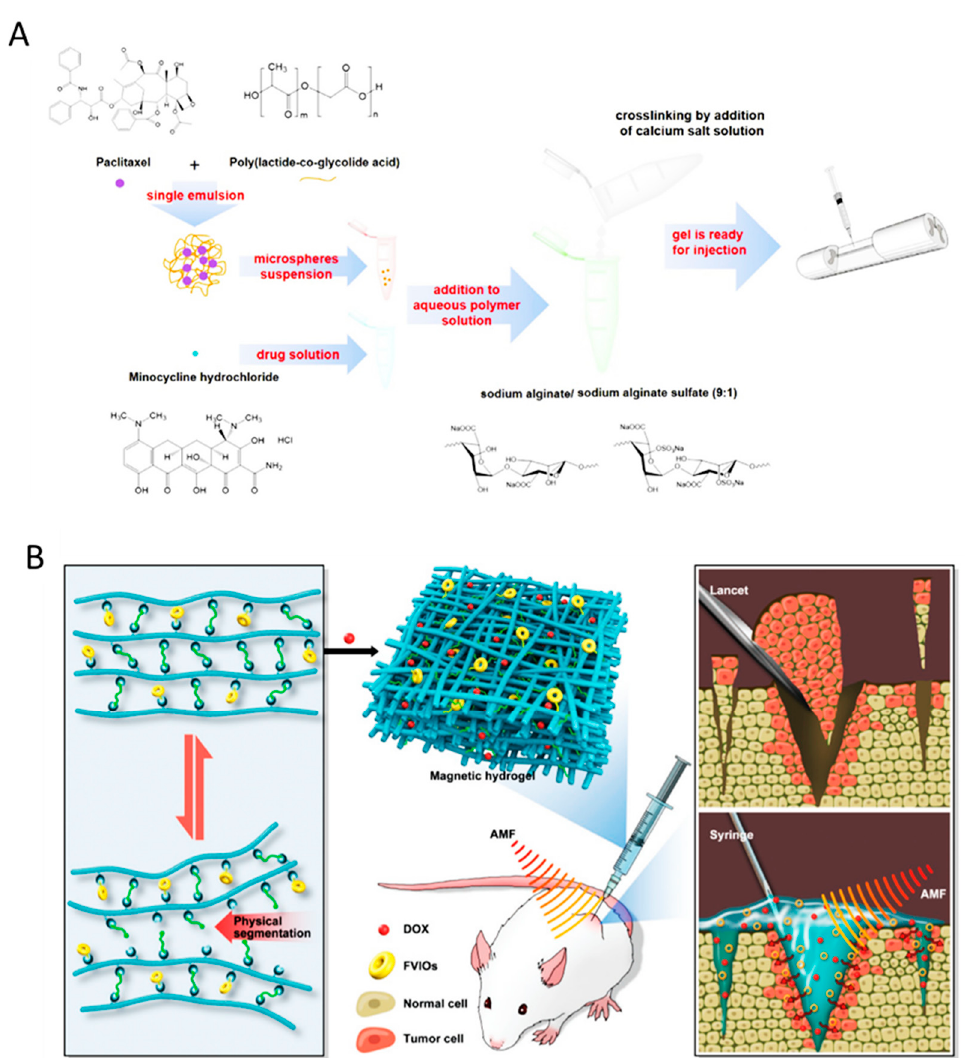
Figure 7. ( A ) Spinal cord injury treatment using alginate hydrogel preparation encapsulated with multi-drug loaded PLGA particles for injection into the lesion site. Adapted with permission from Nazemi et al. [145]. ( B ) Localized administration of vortex-domain iron oxide-functionalized magnetic hydrogel for breast cancer postoperative recurrence prevention using its pH-responsivity. Adapted with permission from Gao et al. [148].